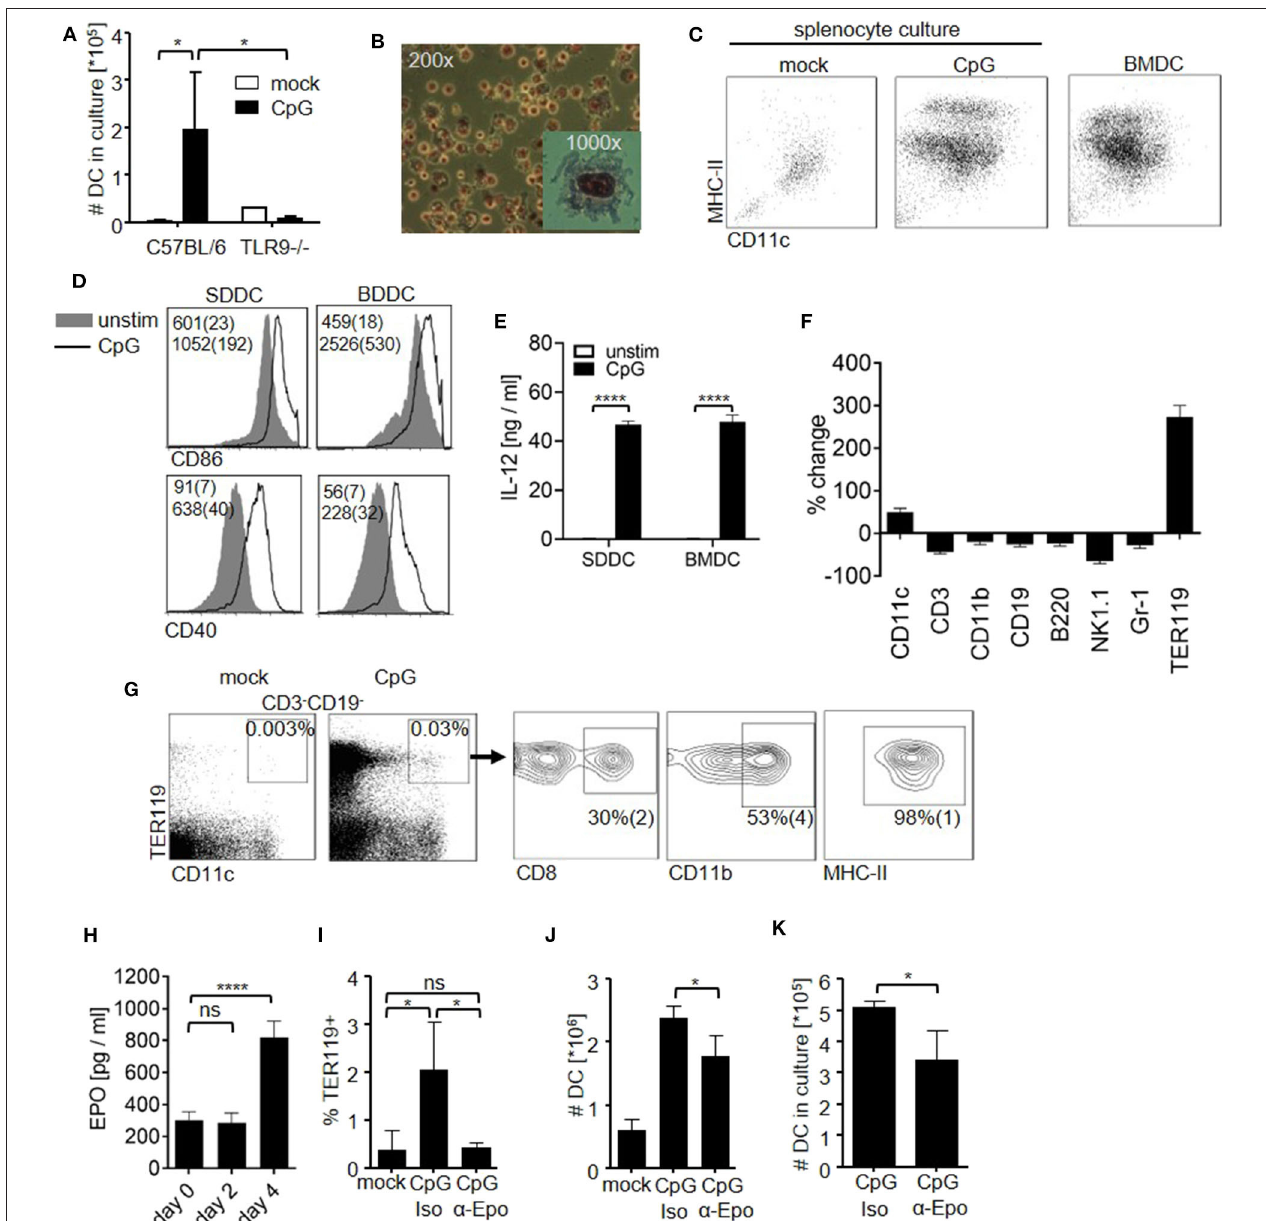
FIGURE 1 | CpG-ODN stimulation induces an EPO-dependent increase in DC in the spleen. (A–E) C57BL/6 controls and TLR9-deficient mice (TLR9 − / − ) received a single dose of CpG-ODN. At day 6 post stimulation, harvested spleens were homogenized and splenocytes (4 × 10 5 cells/ml) were cultured with GM-CSF for 10 days. (A) Graph shows number of DC obtained in culture. (B) Giemsa staining of splenocyte culture derived from CpG-ODN–treated C57BL/6 mice. (C) Surface phenotype of cells from splenocyte culture as determined by flow cytometry. DC generated from bone marrow (BMDC) were included as controls. Representative dot blots are shown. (D,E) DC derived from splenocyte culture (SDDC) and from bone marrow culture (BMDC) were stimulated with CpG-ODN. (D) Representative histograms show expression of CD86 and CD40 on DC. Numbers indicate MFI (median (SD)). (E) Bar graphs show IL-12p40 in cell culture supernatant. (F,G) C57BL/6 mice were stimulated with CpG-ODN and splenocytes were examined by flow cytometry at day 6 post treatment. (F) Splenocytes were stained for canonical lineage markers. Graph shows %-change of indicated populations compared to untreated controls. (G) Blots show surface phenotype of CD3 − CD19 − splenocytes. Data of the animal representing the median of n = 5 animals are shown. (H) EPO levels in blood serum at the indicated time points after CpG-ODN treatment. (I–K) C57BL/6 mice were stimulated with CpG-ODN and received monoclonal anti-erythropoietin antibody ( α -Epo) or isotype control (Iso). Graphs show (I) proportion of TER119 + cells in the splenic DC compartment, (J) total number of DC in the spleen at day 6 post stimulation and (K) number of DC after culture of splenocytes (5 × 10 5 cells/ml) with GM-CSF for 10 days. (A–K) Representative data of at least 3 experiments with n = 3–5 animals/group are shown. (A,E,H–K) Bar graphs show mean (SD). One-way ANOVA with Bonferroni’s post test (A,I) or Student’s t test were performed (E,H,J,K) . Statistical significance is indicated by * = p < 0.05, **** = p < 0.0001, ns = p > 0.05.